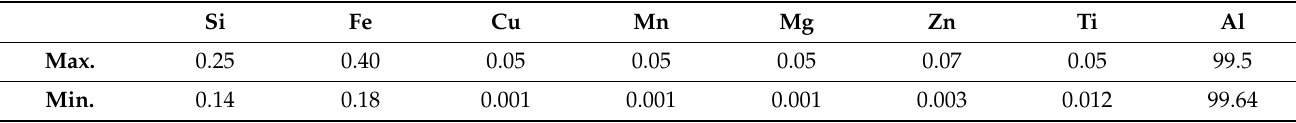
Table A1. The composition table of the material, including the min. and max. percentages of impurities and the corresponding contents of Al